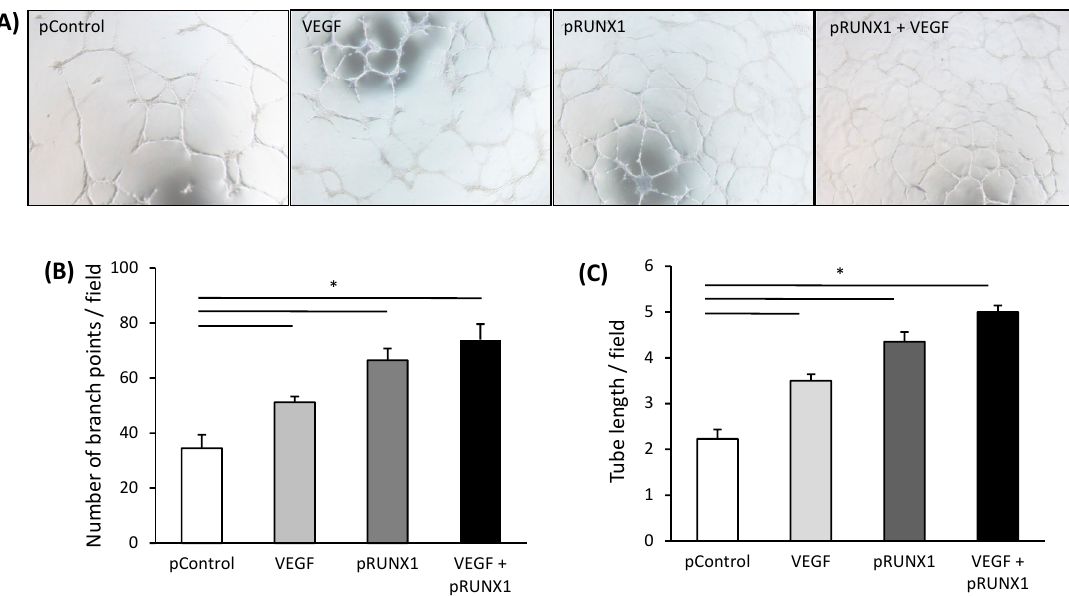
Figure 5. RUNX1 enhances the angiogenic activitiy of endothelial cells. ( A ) Representative tube formation images of HUVECs on matrigel (4 × objective) transfected with RUNX1 expression plasmid (pRUNX1), control plasmid (pControl, empty vector) and / or incubated with VEGF (10 ng / mL). ( B ) Average number of branch points per field and ( C ) tube length per field formed by HUVECs on matrigel under conditions described in ( A ) ( n = 3). Data represent mean ± SD. * p < 0.05.